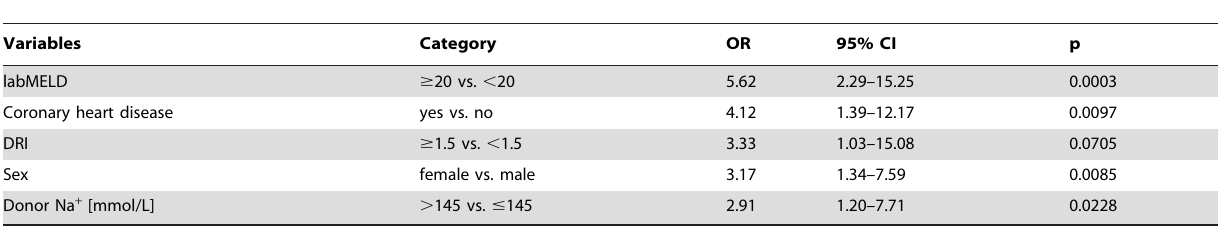
Table 5. Multivariate, logistic regression analysis of patient survival rates.